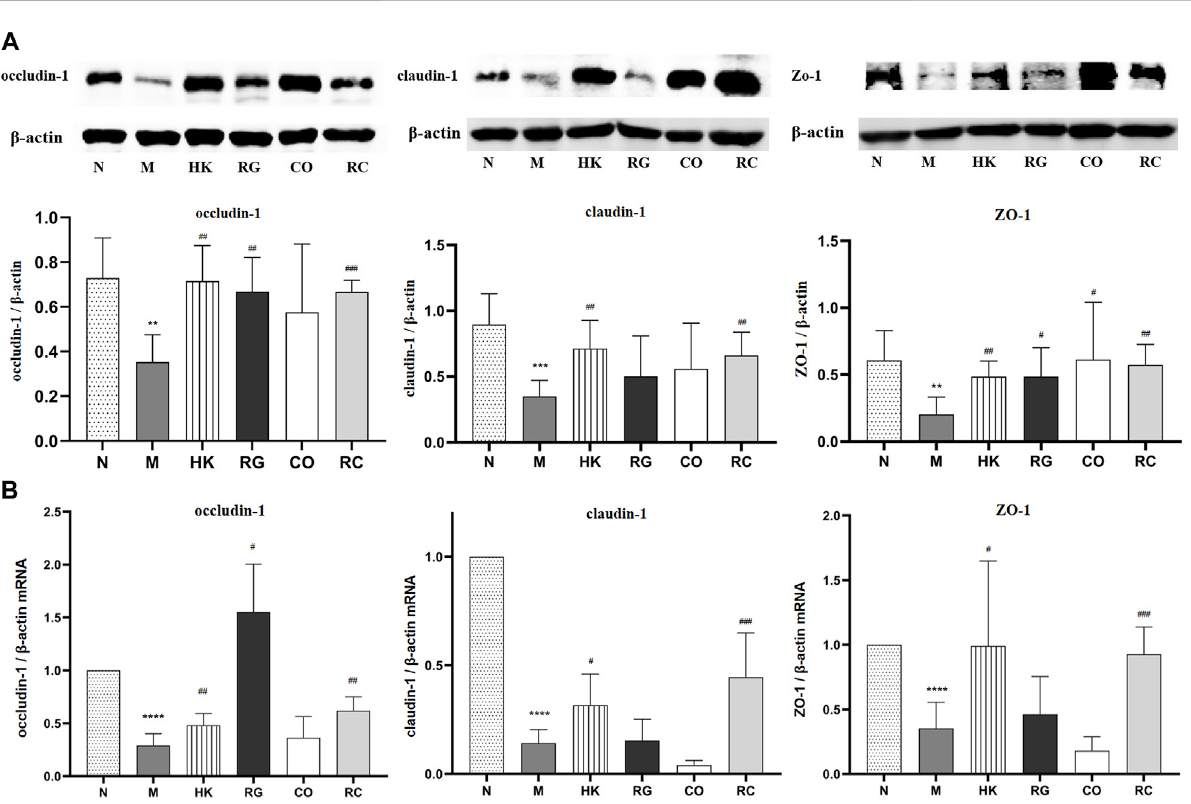
FIGURE 5 (A) Effects of RG, CO, and RC on the expressions of occludin-1, ZO-1, and claudin-1 in CKD rats. (B) Effects of RG, CO, and RC on the mRNA levels of occludin-1, ZO-1, and claudin-1 in CKD rats. (Data are means ± SD. **** p < 0.0001 vs . normal group; ### p < 0.001, ## p < 0.01, and # p < 0.05 vs . model group. n =